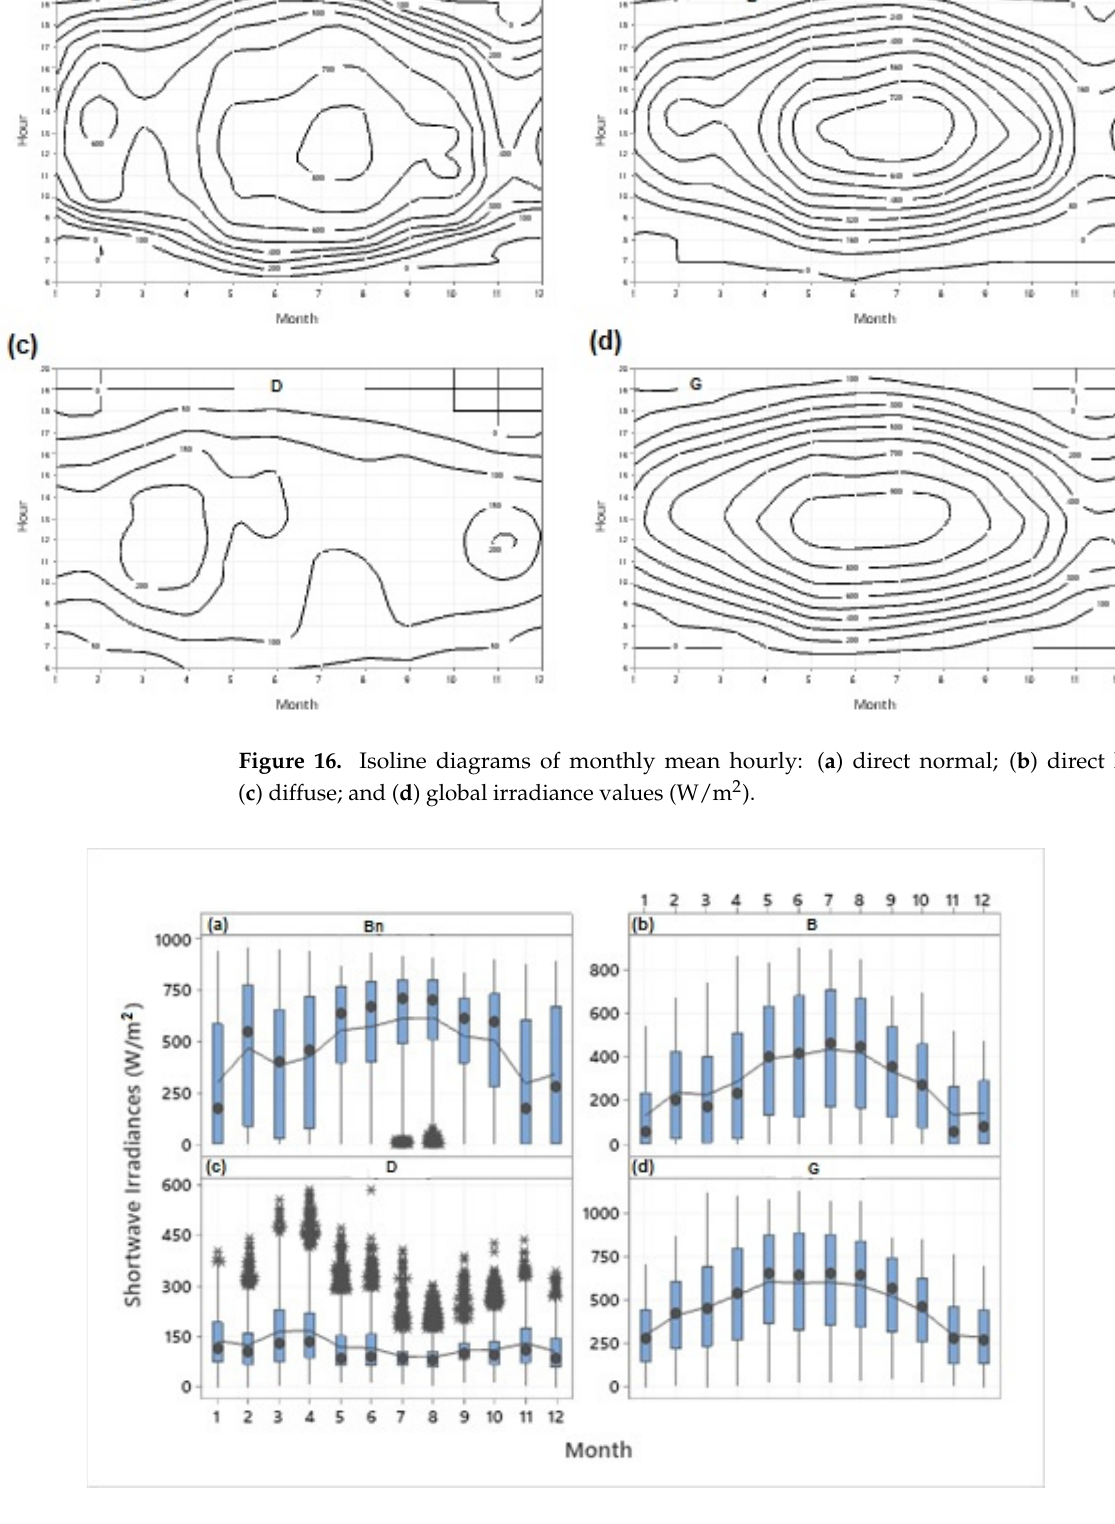
Figure 17. Boxplots of irradiances of the shortwave radiation components: ( a ) direct normal ( B n ); ( b ) direct horizontal ( B ); ( c ) diffuse ( D ); and ( d ) global ( G ). The symbol of median values is represented as circle in the boxplot. The asterisks denote the outliers. The smooth curve represents the mean values of each month of the year.